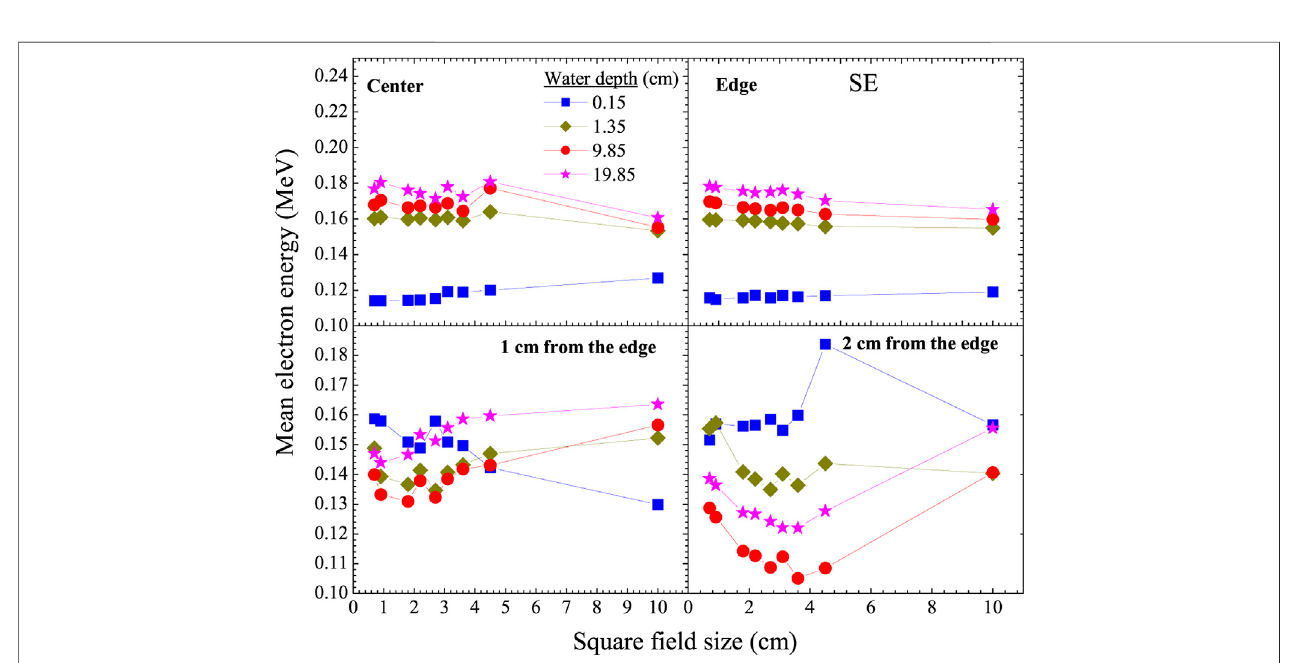
FIGURE 5 | Mean electron energy for the SE fl uence as a function of square FS for four water depths and several OADs.